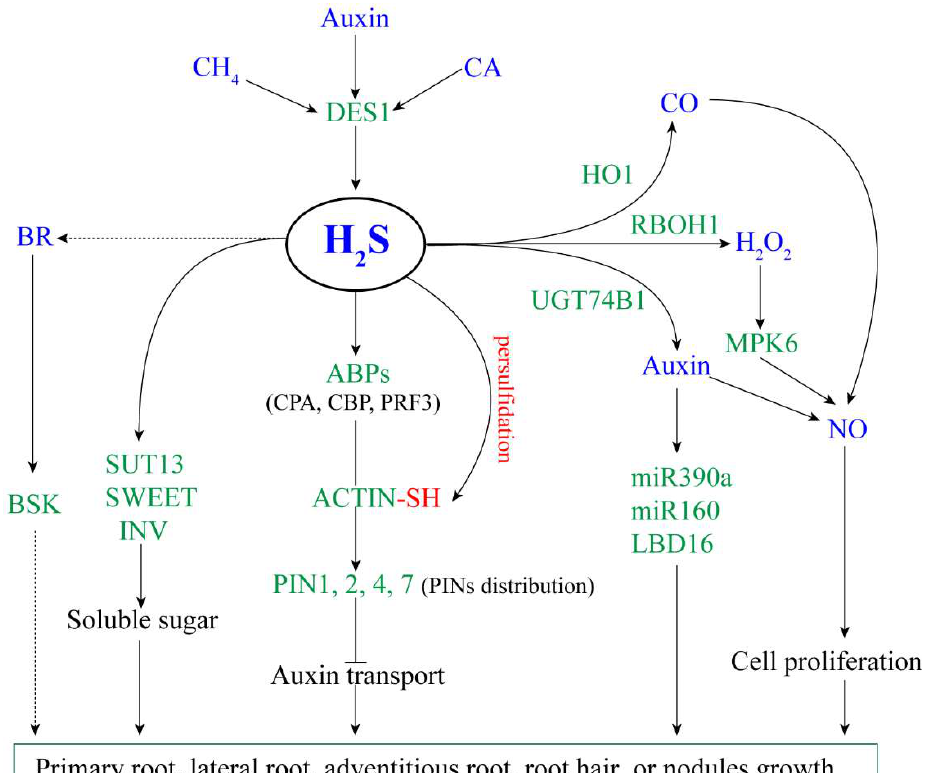
Figure 1. The proposed model of H 2 S regulating plant root growth. Arrow and bar ends indicate activation and inhibitory effects, respectively. Green fonts represent genes or proteins, blue fonts represent signal molecules. H 2 S: hydrogen sulfide; CH 4 : methane; CA: cinnamaldehyde; BR: brassinosteroid; CO: carbon monoxide; NO: nitric oxide; DES1: L-cysteine desulfhydrase 1; HO1: haem oxygenase-1; RBOH1: respiratory burst oxidase 1; UGT74B1: UDP-glycosyltransferase 74B1; MPK6: mitogen-activated protein kinase 6; ABPs: actin-binding proteins; PINs: pin-formed family; SUT13: sugar transport protein 13; SWEET: bidirectional sugar transporter; INV: invertase; BSK: BR-signaling kinase; LBD16: LOB domain-containing protein 16.